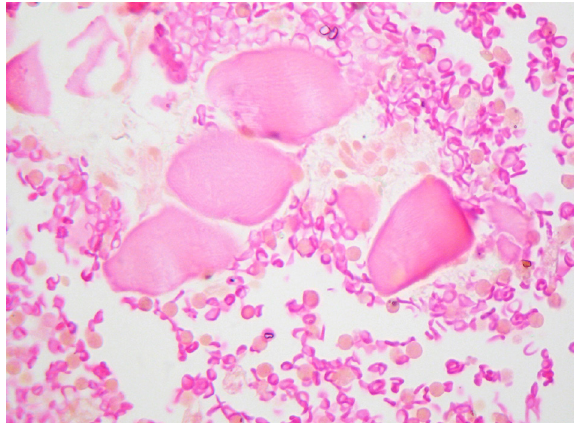
Figure 3. Presence of acellular amorphous eosinophilic material (H&E 100x).